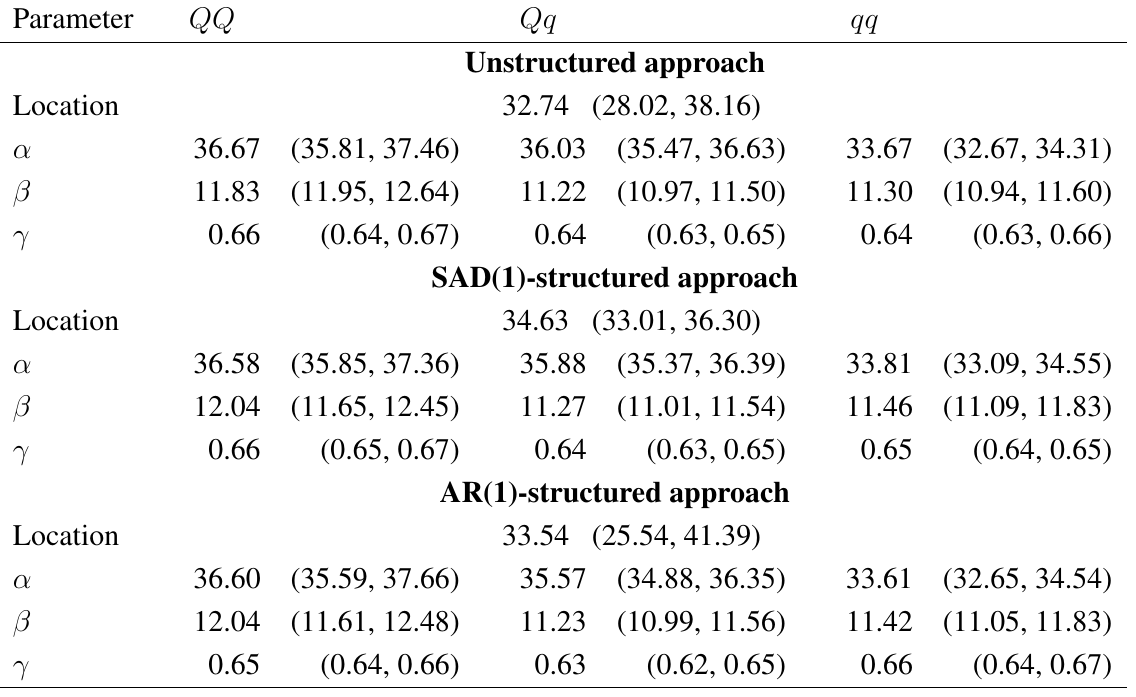
Table 2. Bayesian estimates of QTL locations and genotype-specific growth curves for an assumed QTL from the simulated data set for an F different covariance-structuring approaches. Numbers in parentheses are the 95% equal-tail confidence